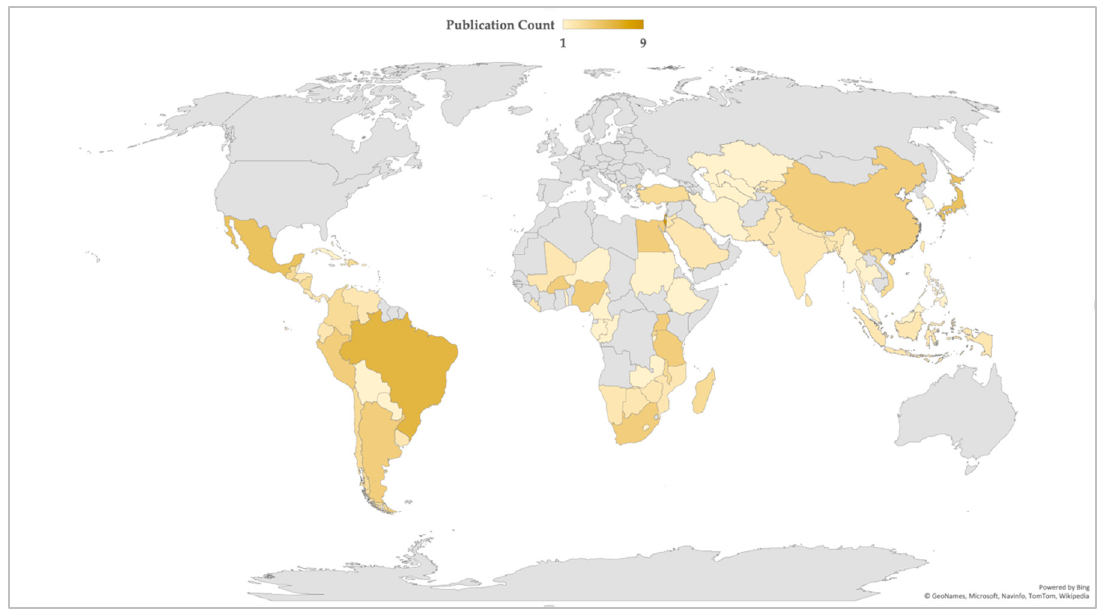
Figure 3. Map of publication count by country, showing within-region inequality. Source: Author created.